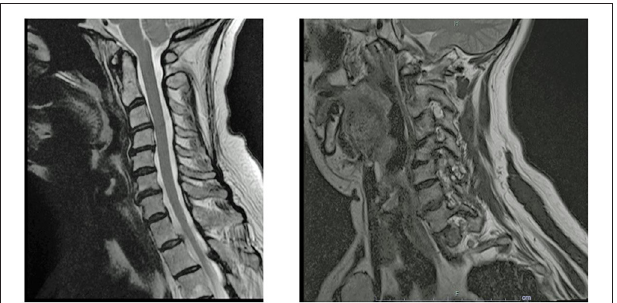
FIGURE 1 | MRI impression: Bilateral foraminal stenosis at C4 and C5, related to uncovertebral arthropathy, with exiting C5 nerve root impingement. At C5–C6, there is significant right foraminal stenosis with exiting C6 nerve root impingement. Photo courtesy of Joseph A. Marchione, MD, Neuroradiologist at Garnet Health Medical